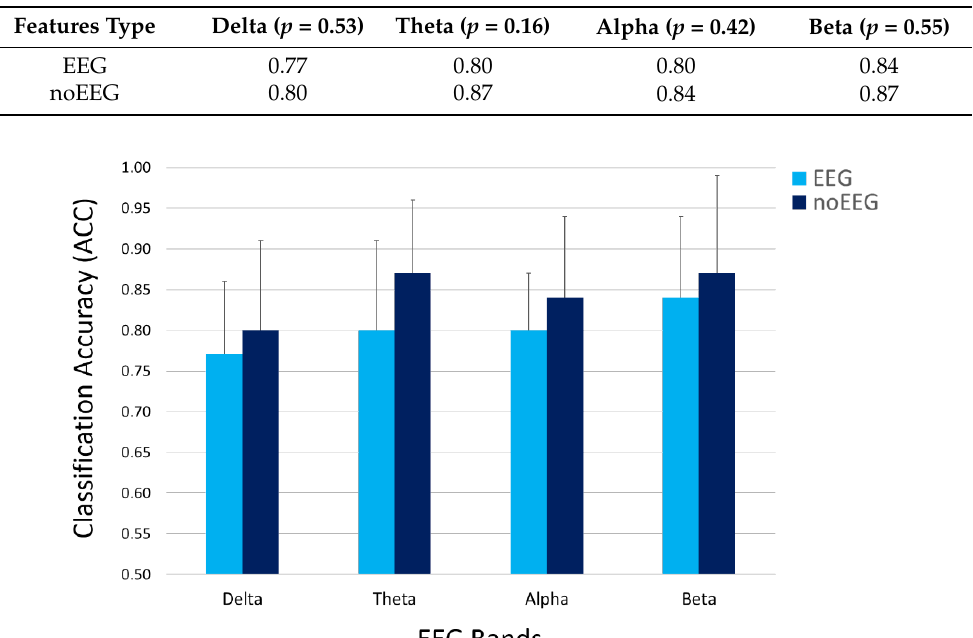
Figure 6. The averaged AUCs assumed values higher than 0.7 as a demonstration of good OA-OC discrimination in all the considered EEG bands. In addition, the t-tests on the averaged AUCs did not report significant (all p > 0.05) differences between the OC-OA discriminations obtained when using only the EEG or only the noEEG features. Table 4. Summary of statistical analysis on the classification accuracy. Specifically, for each EEG band and features type, the ACCs and p -value were reported.